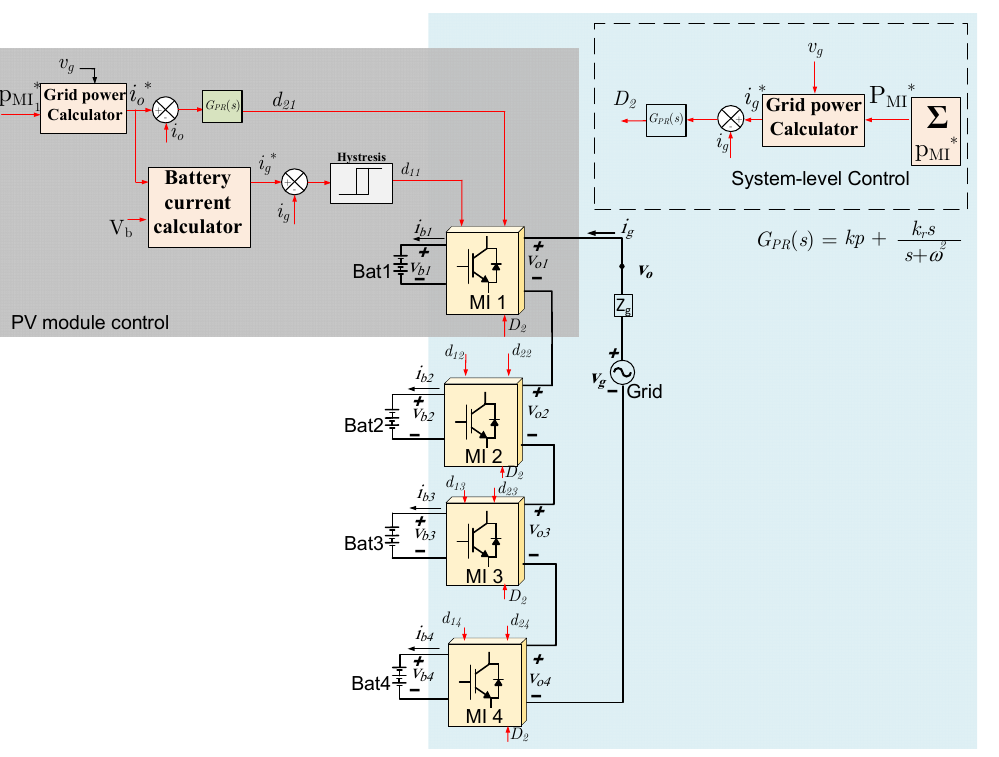
Figure 21. PV module and system-level controllers for grid/battery AC/DC rectification.